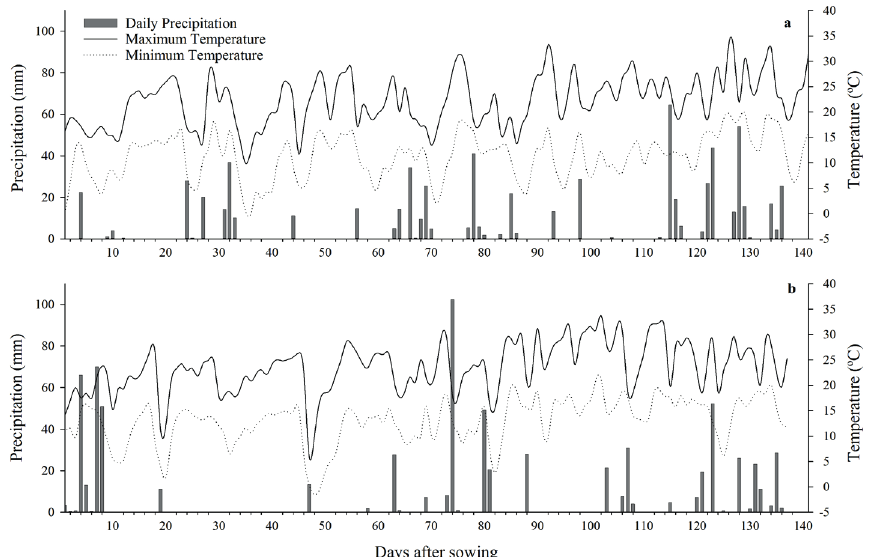
Figure 1 - Meteorological data of daily precipitation, maximum and minimum temperatures during black oat cultivation period in 2016 ( a ) and 2017 ( b ) agricultural years. Source: INMET, (Frederico Westphalen - A854) Frederico Westphalen – RS automatic weather station.